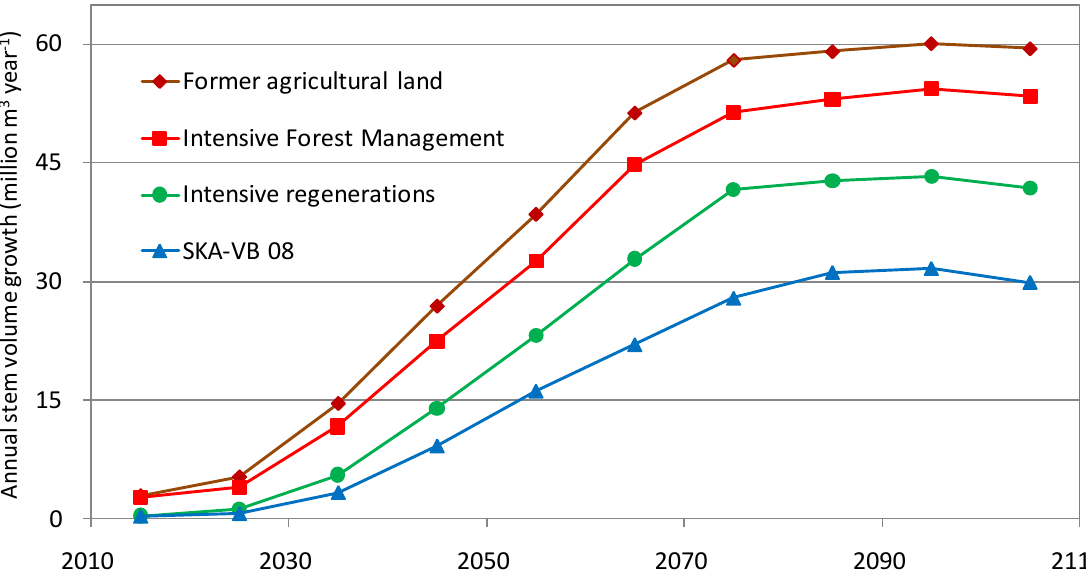
Figure 4. Simulated annual stem volume growth (million m 3 year −1 ) according to the reference scenario (SKA-VB 08) without (blue line) and with intensive reforestation (green line). The total effect of intensive forest management (IFM) is shown without (red line) and with (brown line) the contribution from afforestation of former agricultural land. For further explanations, see